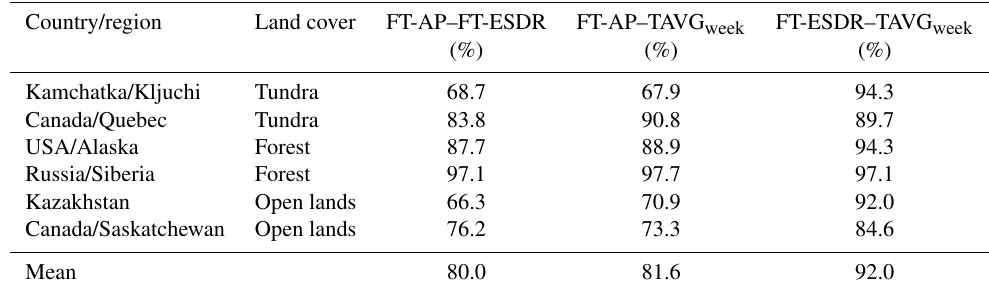
Figure 5. Thaw onset maps, where colors indicate the week of year, for (a) 2012, (b) 2013 and (c) 2013 with FT-AP (top), FT-ESDR (middle) and difference between the products (Diff. = FT-AP minus FT-ESDR; bottom). Table 5. Agreement (%) of weekly FT detections between FT-AP and FT-ESDR and between satellite products and in situ data (TAVG week ) for each site over the entire period. The sites are defined in Table